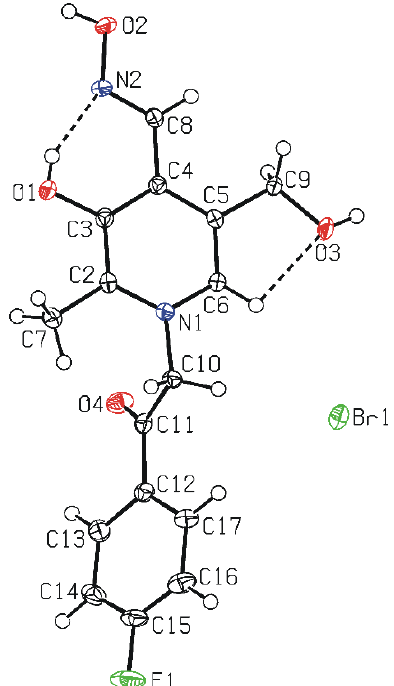
Figure 1. A molecular structure of 7 , with the atom-numbering scheme. Displacement ellipsoids for non-hydrogen atoms are drawn at the 50% probability